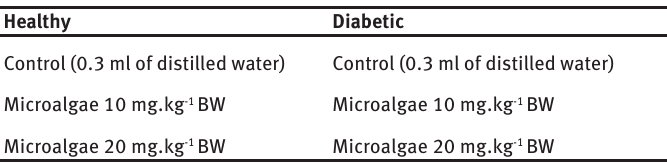
Table1: Experimental groups (BW= body weight).